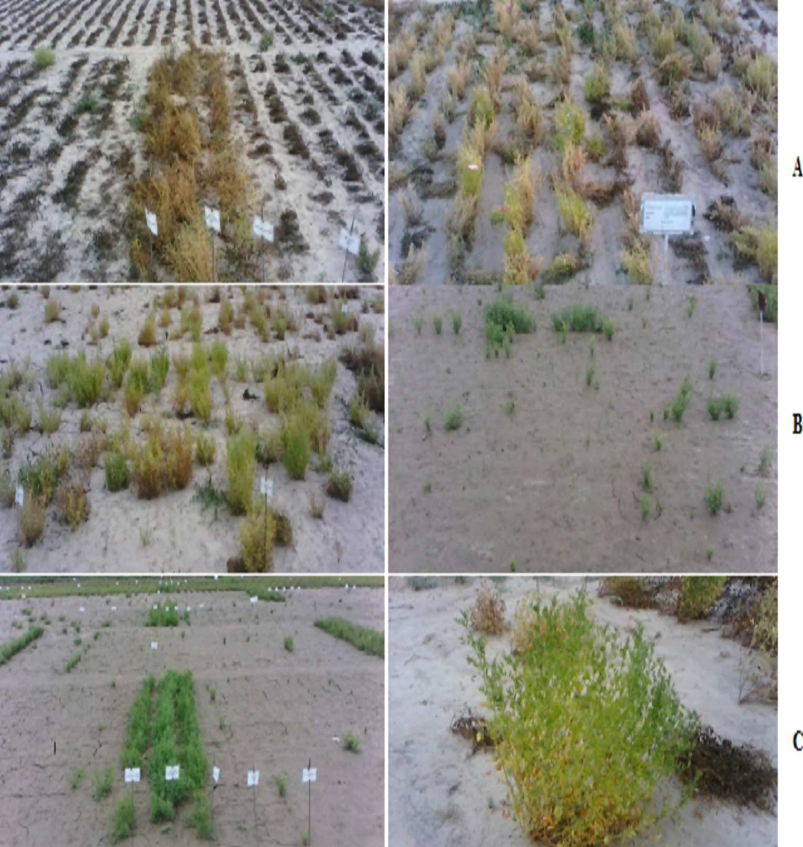
Fig 6. Reactionof M 2 populations of lentil againstdifferent herbicidesin screeningthrough different methods (A = Post plant emergence, B = Pre-plant incorporation and C = Seed priming).